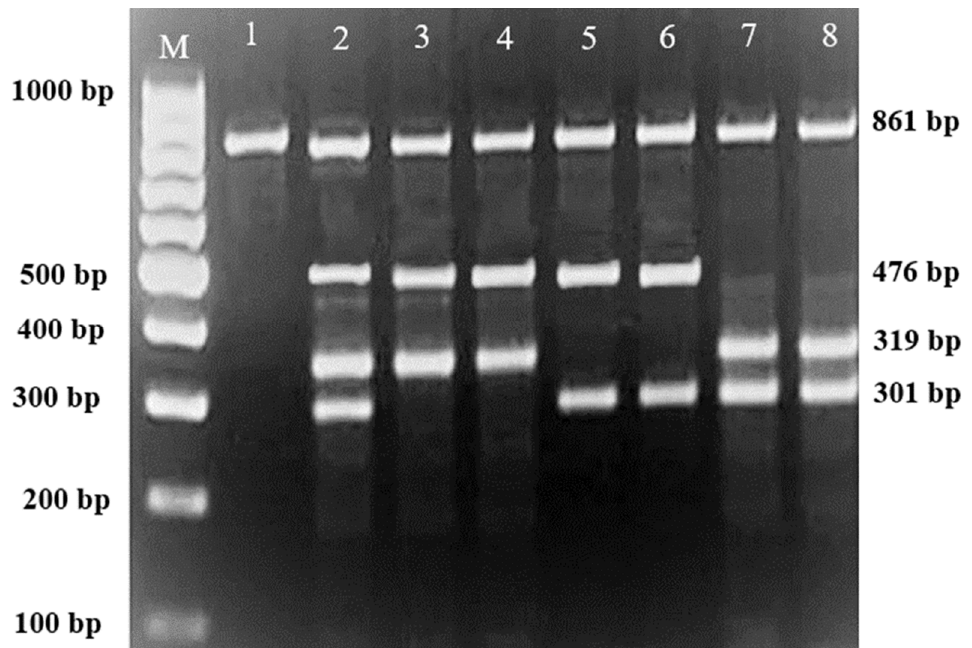
Figure 1. 2% Agarose gel for MARMS A-PCR M is a 100 bp marker; lane 1 is a positive control for 861 bp common A primer; Lane 2 is a positive control for triplicate mutation Cd 41/42 (-TTCT), IVS 1-5 (G>C), and Cd 26 (G>A); Lane 3 and Lane 4 are positive for compound heterozygous Cd 41/42 (-TTCT) and IVS 1-5 (G>C); Lane 5 and 6 are positive for compound heterozygous Cd 41/42 (-TTCT) and Cd 26 (G>A); Lane 7 and 8 are positive for compound heterozygous IVS 1-5 (G>C) and Cd 26 (G>A).